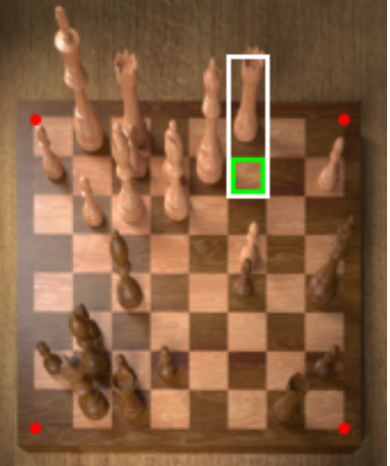
Figure 5. An example illustrating why an immediate piece classification approach is prone to report- ing false positives. Consider the square marked in green. Its bounding box for piece classification (marked in white) must be quite tall to accomodate tall pieces like a queen or king (the box must be at least as tall as the queen in the adjacent square on the left). The resulting sample contains almost the entire rook of the square behind, leading to a false positive.